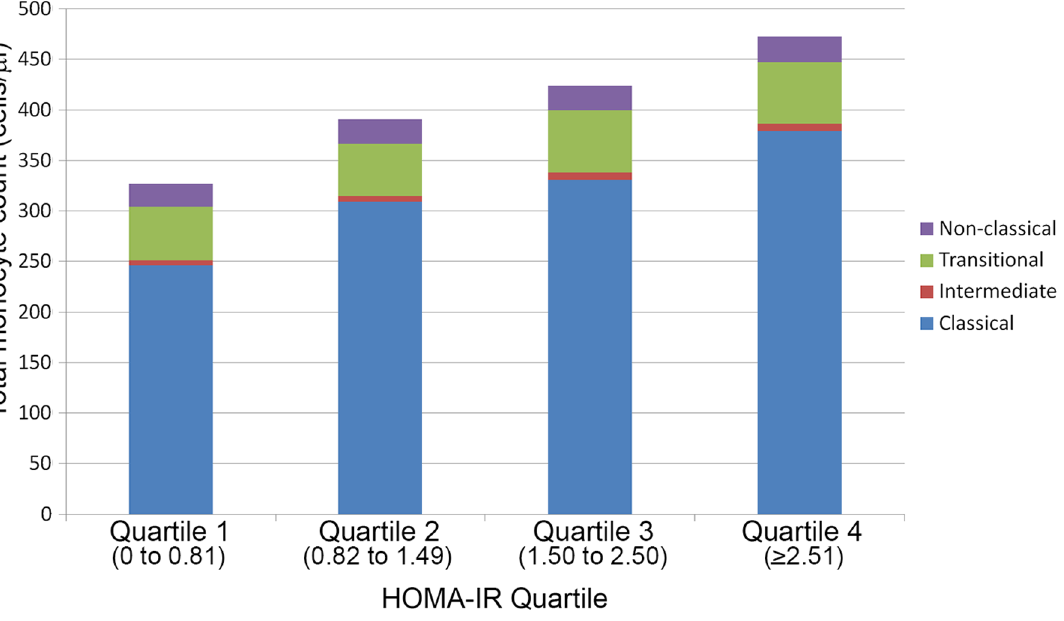
Figure 3. Absolute counts (cells/ m L) of total monocytes by classical, intermediate, transitional and non-classical monocyte subset components by HOMA-IR quartiles.